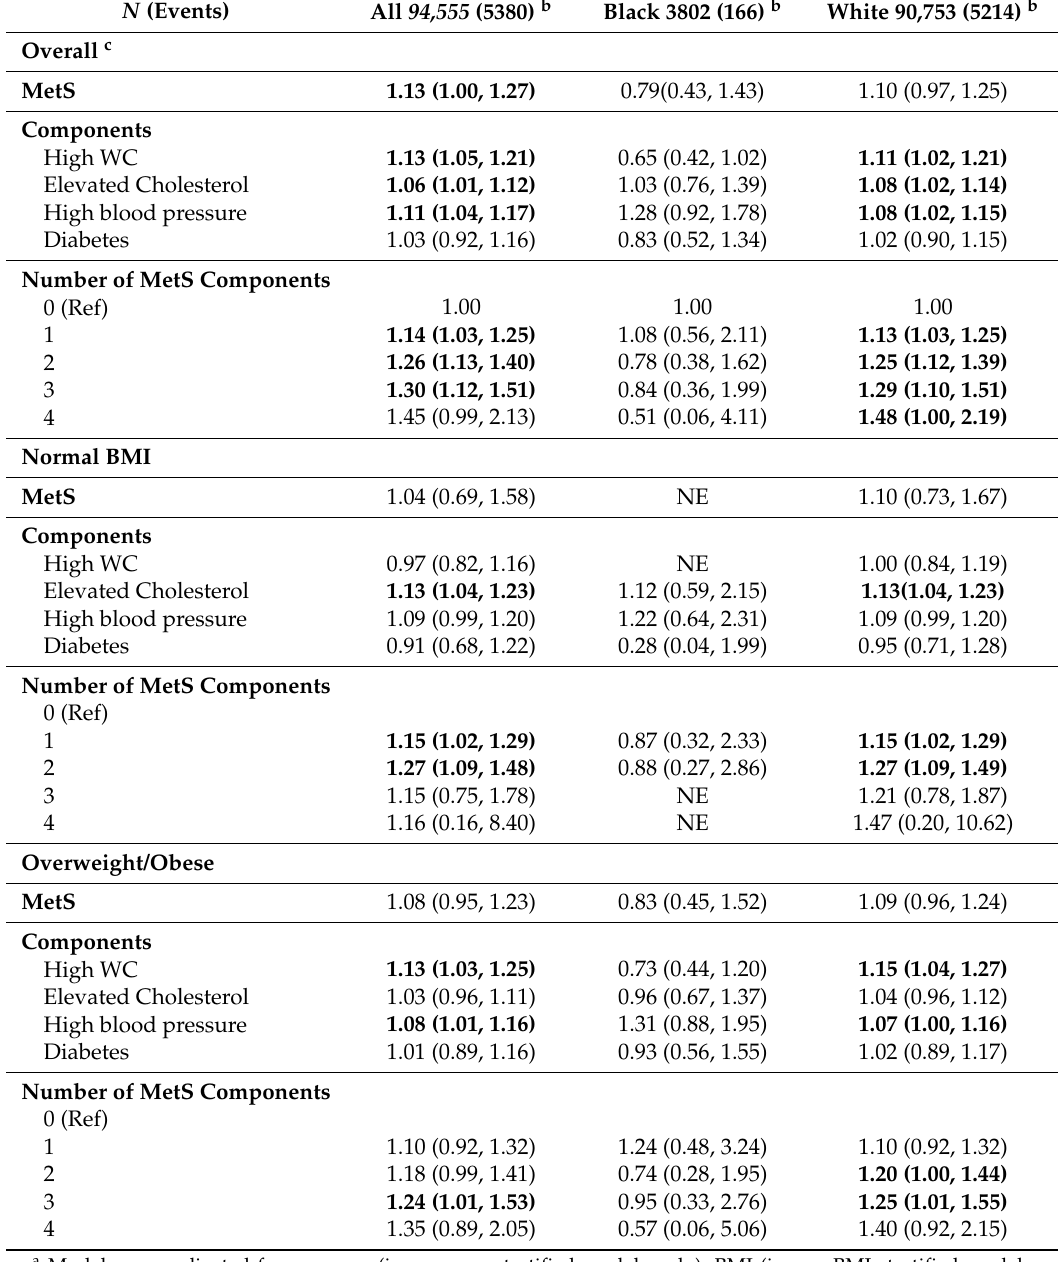
Table 2. Hazard ratios (HRs) a and 95% confidence intervals (CI) for metabolic syndrome (MetS) and breast cancer risk by body mass index (BMI) and